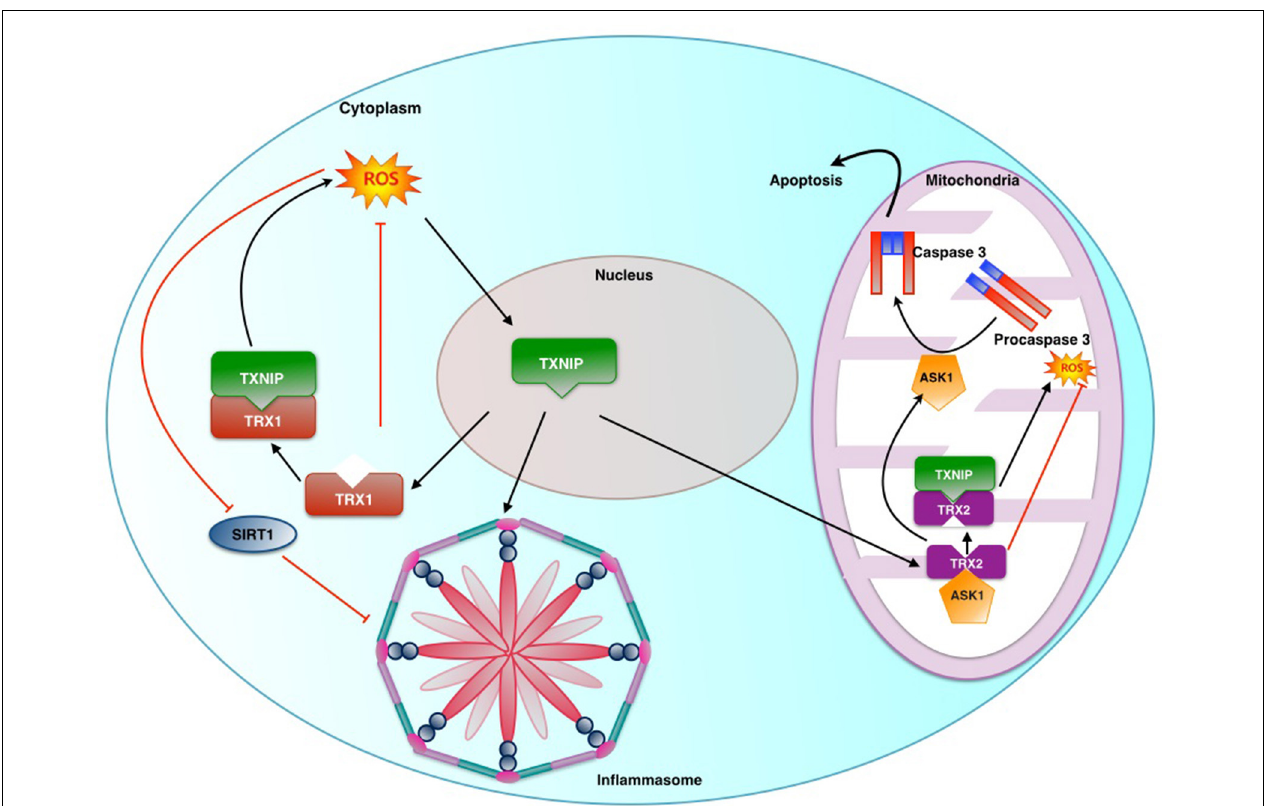
FIGURE 2 | Role played by Thioredoxin Interactive Protein (TXNIP) and Sirtuin in ROS induced inflammasome activation: Thioredoxin-1 (TRX1) and Thioredoxin-2 (TRX2) are part of key anti-oxidant systems in cytoplasm and mitochondria respectively. Under stress TXNIP is transferred from its usual location of nucleus to mitochondria and cytosol. TXNIP in the nucleus binds to TRX2 uncoupling it from